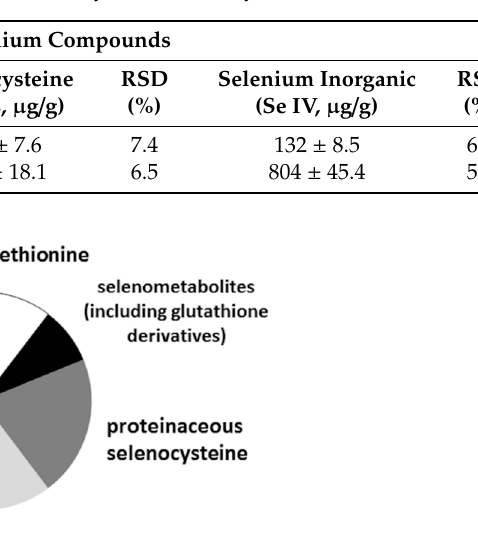
Table 3. Results of selenium speciation analysis of Candida yeast.